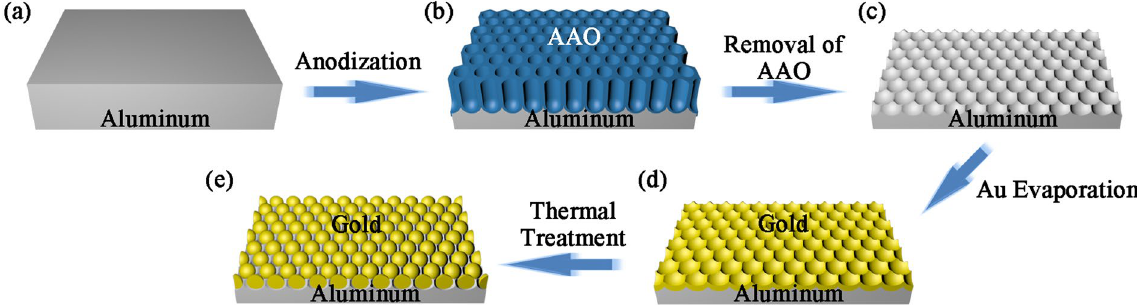
Figure 1. Schematic illustrations of the preparation of Al nanobowl array template and subsequent SSD process for Au nanoparticles assembly: ( a ) pretreated Al foil, ( b ) AAO template after anodization, ( c ) Al nanobowl array template after removal of AAO, ( d ) the Au-coated Al nanobowl array after thermal deposition, ( e ) Au nanoparticle array assembled by SSD process.